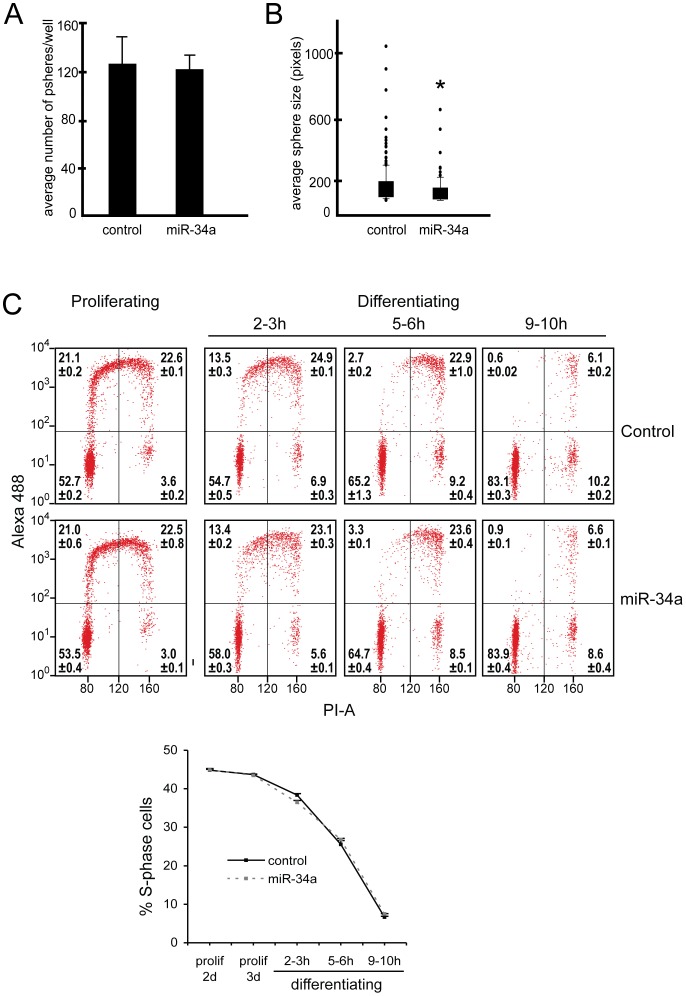
Cell cycle analysis.NPC established from E15.5 were infected with miR-34a-expressing or control lentiviral vectors and proliferation parameters assessed. A and B) In non-differentiation conditions, NPC transduced with FIVGFP (control) or FIVGFP34a (miR-34a) were dissociated and plated at low density and one week later neurospheres were counted (A, bar graphs) and sphere size measured and (B, box plots). For neurosphere counts, bars represent the mean ± SD of three independent cultures. For sphere size, data was combined from three independent cultures. Boxes encompass 25th-75th percentile and whiskers mark 10th and 90th percentiles. *p<0.001, for miR-34a over-expressing compared to control. C) NPC transduced with FIVneorU6cntrl (control) or FIVneorU634a (miR-34a) were BrdU-pulsed for 1 h under proliferating conditions (2 or 3 days after passage), or were seeded into differentiation media and BrdU-pulsed at 2–3 h, 5–6 h, or 9–10 h post-seeding. Cells were collected directly after pulse and analyzed for BrdU incorporation (A488 intensity) and DNA content (PI-A). Representative dot-plots are shown, and quadrant statistics for 3 replicate experiments are displayed on the dot-plots (mean ±SEM). The line graph illustrates the proportion of cells in S-phase (BrdU positive cells, mean ±SEM of the three experiments). No significant differences in cell cycle distribution were determined (p>0.05 for miR-34a vs control).